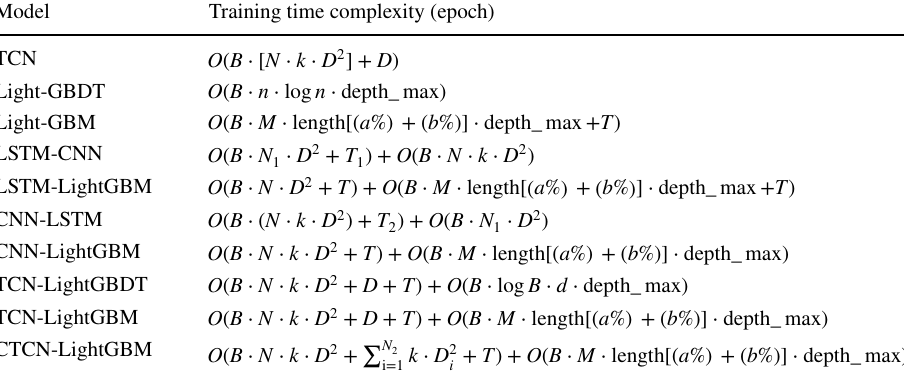
Model Training time complexity